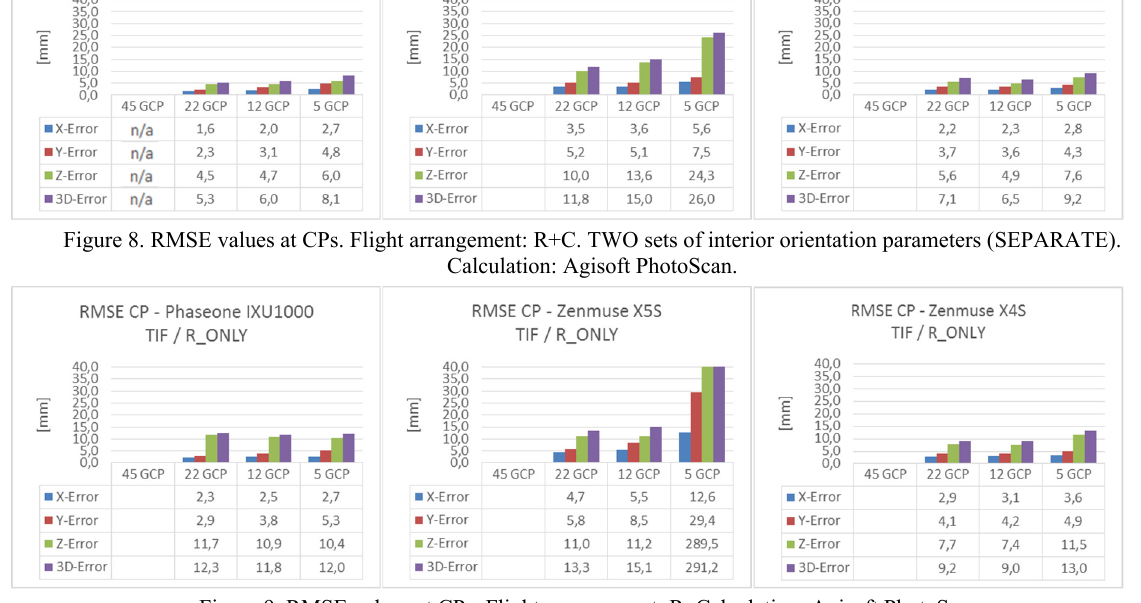
Figure 9. RMSE values at CPs. Flight arrangement: R. Calculation: Agisoft